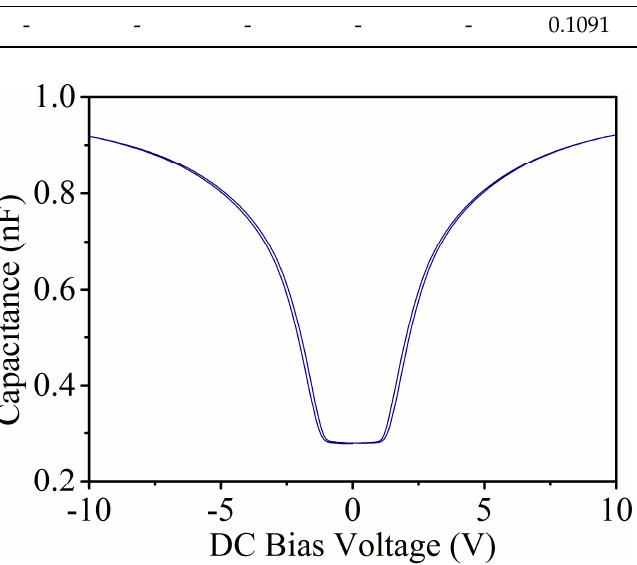
Figure 6. Voltage-dependence capacitance hysteresis characteristic of the cell fabricated from 2.0 mg / mL Ag-d-PI thin layers.